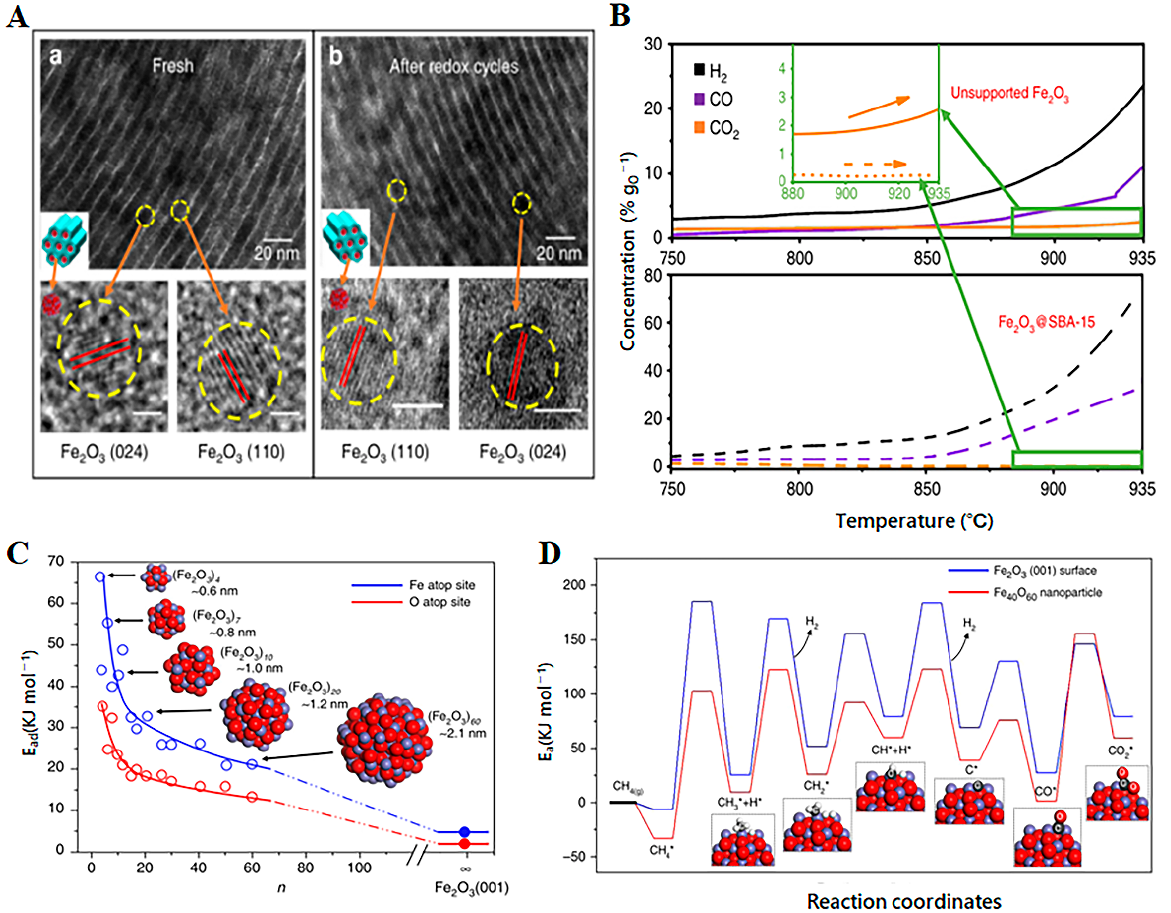
Figure 7. ( A ) Morphological characteristics of Fe 2 O 3 @SBA − 15 OC. ( Aa ) HR − TEM images of fresh Fe 2 O 3 @SBA − 15 and typical Fe 2 O 3 nanoparticles (scale bar of 1 nm); ( Ab ) HR − TEM images of Fe 2 O 3 @SBA − 15 after 75 cycles and typical Fe 2 O 3 nanoparticles (scale bar of 5 nm). ( B ) Temperature programmed reduction profiles of Fe 2 O 3 @SBA − 15 and unsupported Fe 2 O 3 ; ( C ) Calculated results of CH 4 adsorption on Fe atop site and O atop site of (Fe 2 O 3 ) n nanoparticles. ( D ) Energy evolution of CH 4 conversion on Fe 40 O 60 nanoparticle and Fe 2 O 3 (001) surface. Adapted with permission from Ref. [102] , copyright 2019, Nature.